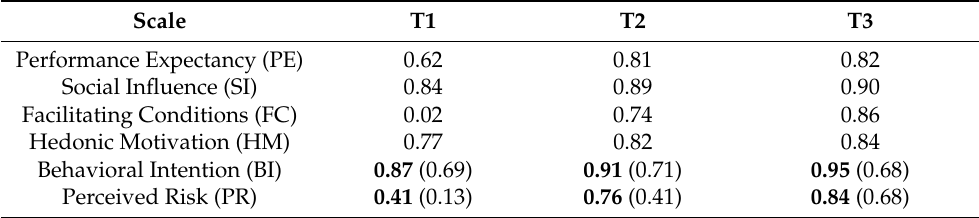
Table 2. Reliability of the UTAUT-2-scales and of the perceived risk